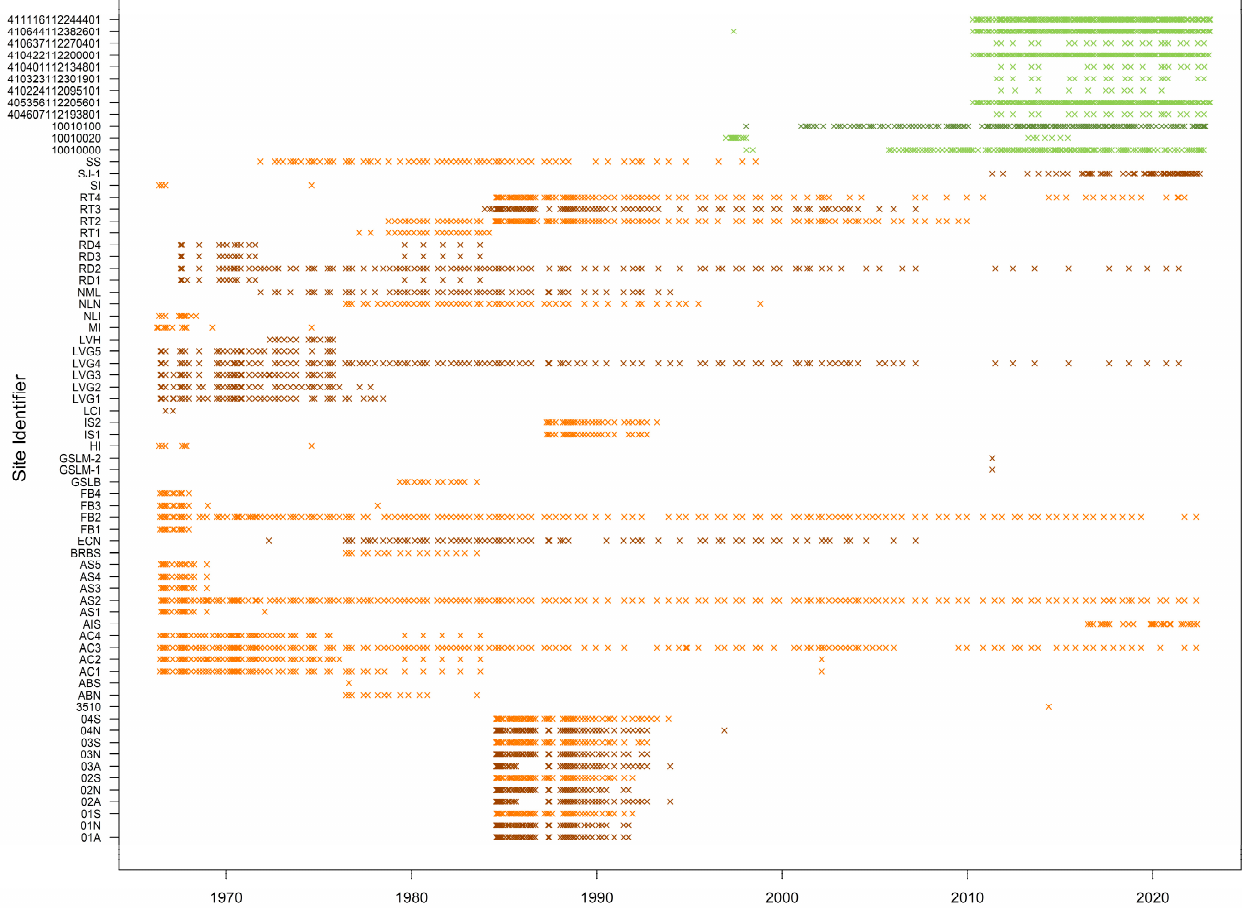
Figure 2. Timeline indicating when the GSL was sampled over the historical record, from 1966 to early 2023, using UGS north arm (dark orange), UGS south arm (light orange), USGS north arm (dark green), and USGS south arm (light green) sites. Each x represents one sampling event.